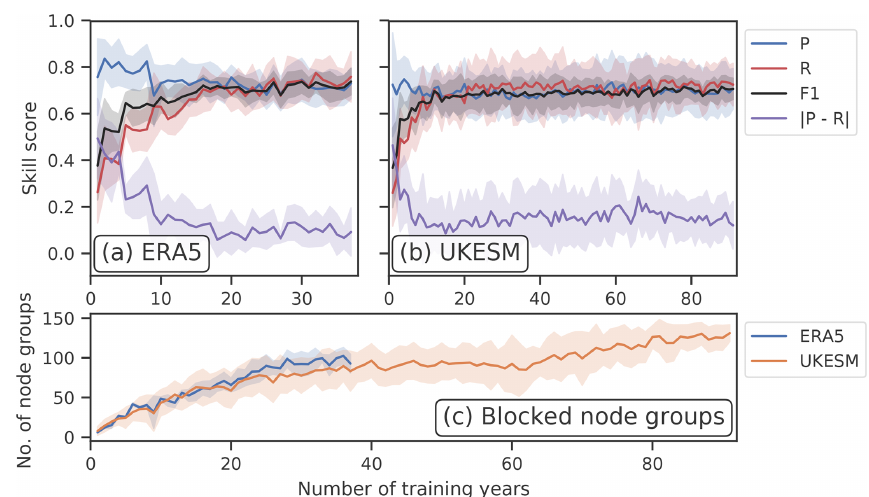
Figure 10. SOM-BI skill depending on the number of training years. Panels (a) and (b) show the skill scores for ERA5 and UKESM, and panel (c) shows how the number of node groups associated with blocking varies with the length of the training record. A 10-fold cross- validation is used, with 4 and 10 years used to test the SOM-BI for ERA5 and UKESM respectively. In both models Z 500 is the variable tested with 20 (5 × 4) nodes in the SOM. Error bands indicate standard deviation ( ± 1 σ ) in the skill scores depending on the training–test set combination.